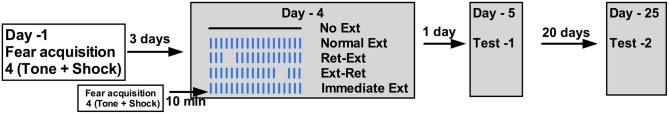
Schema of Experiment 1. Tone; 77dB; 30 s each, Shock = 0.8 mA; 2 s each, Inter trial interval (ITI) = 2 min during fear conditioning in context A. Fear conditioning was done on Day-1 and extinction, test 1 and test 2 were done on Day-4, 5 and 25 respectively. On extinction day in context B, Ret-Ext and Ext-Ret groups received a retrieval session consisting of three massed tones, 5 s ITI and extinction session consisted of 50 massed tones, 5 s ITI. Retrieval and extinction sessions were 10 min apart.